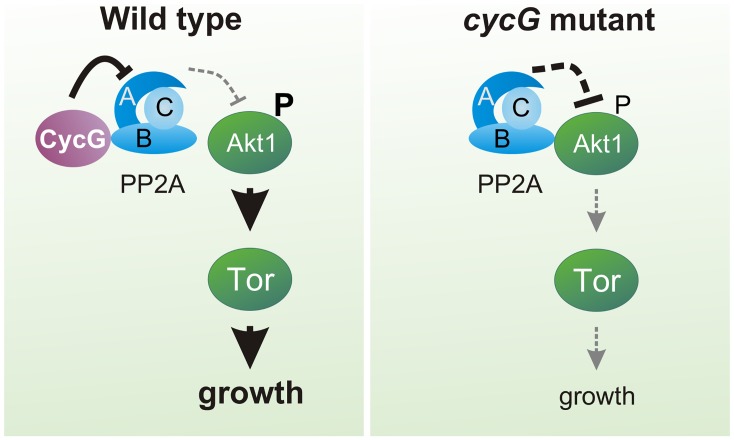
Model of CycG function.In a wild type fly, CycG interacts with a B' subunit of PP2A affecting its binding of Akt1. This leads to a balanced level of InR/TOR signaling mediated growth (left). In cycG deficient flies, Wdb-Akt1 binding is favored and phosphorylation of the central kinase Akt1 is decreased. As a consequence, TOR mediated growth is impaired (right).